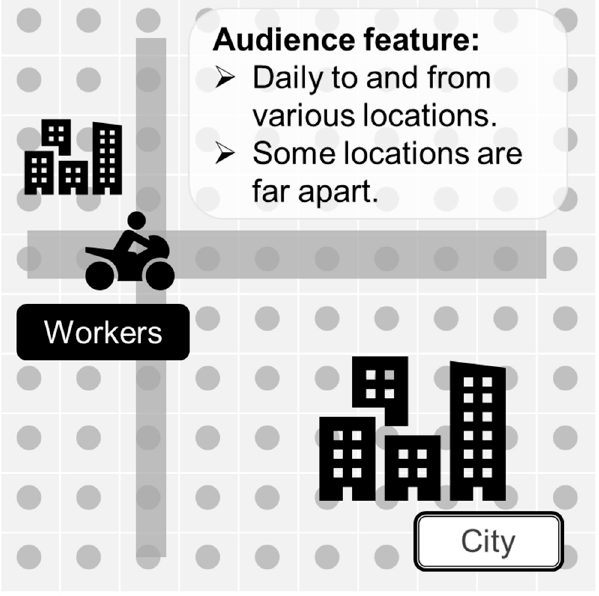
Figure 5. Audience feature in Case 5.